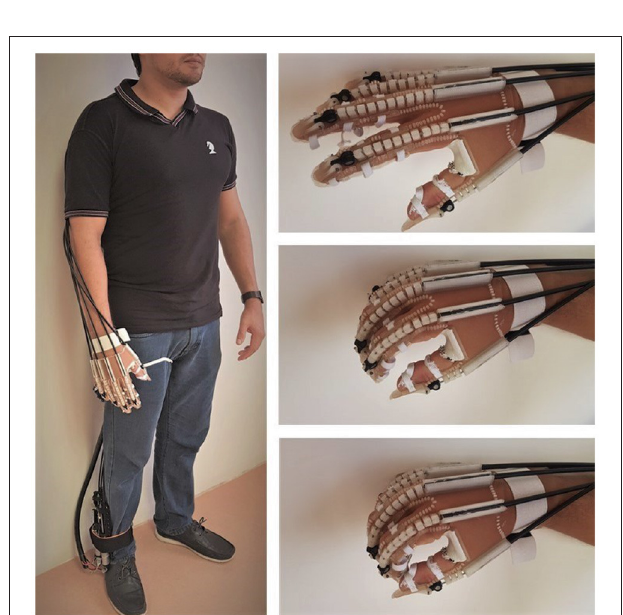
FIGURE 10 | The Hand Exoskeleton for Rehabilitation Objectives (HERO) attached to the body. The actuators were attached to the right lower limb, on the same side of the exoskeleton glove, only for illustration. Patients should have the actuators attached to their healthy lower